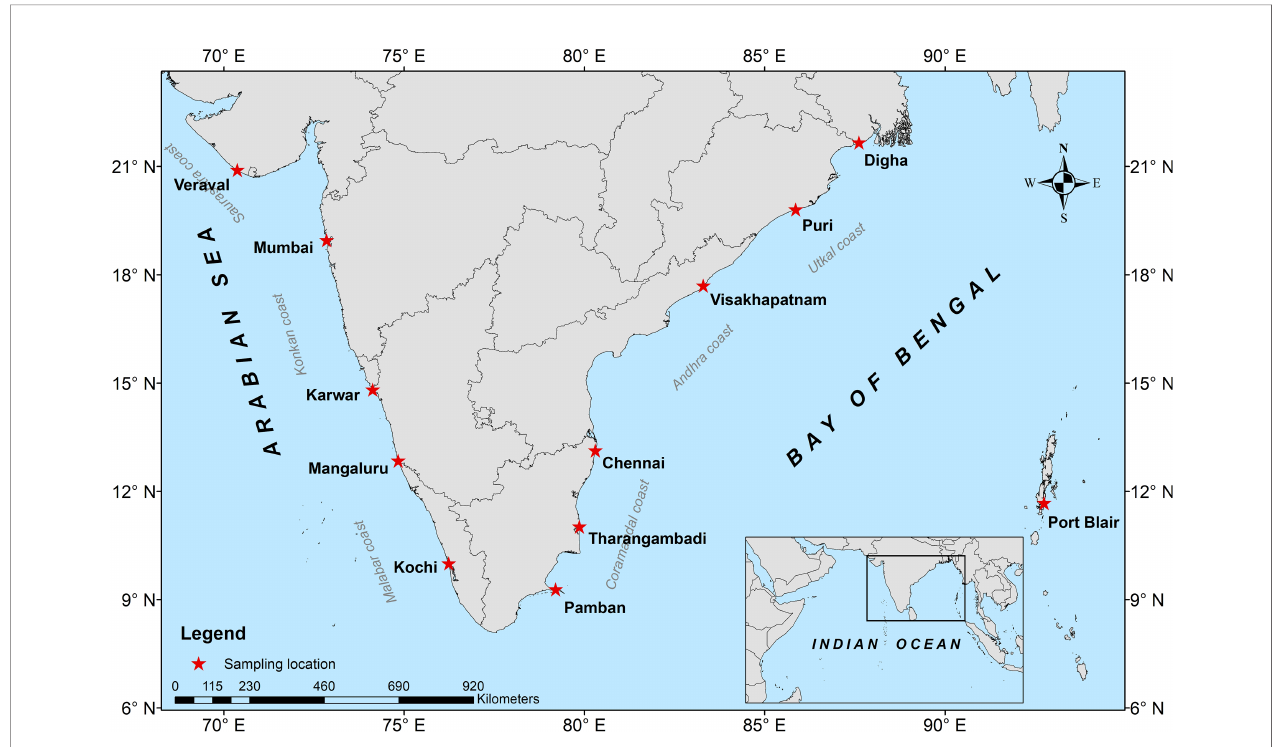
FIGURE 1 | Map showing the sampling locations of Scomberomorus spp. along the Indian